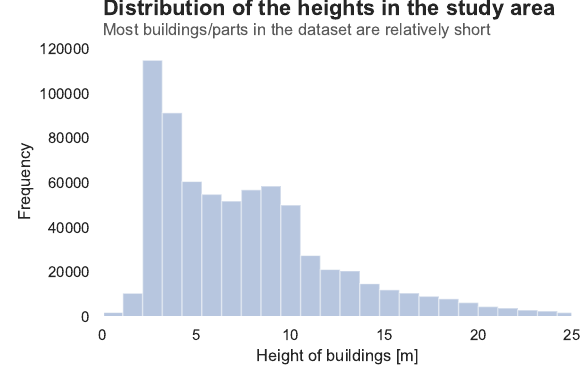
Figure 3. Distribution of heights of buildings/parts.